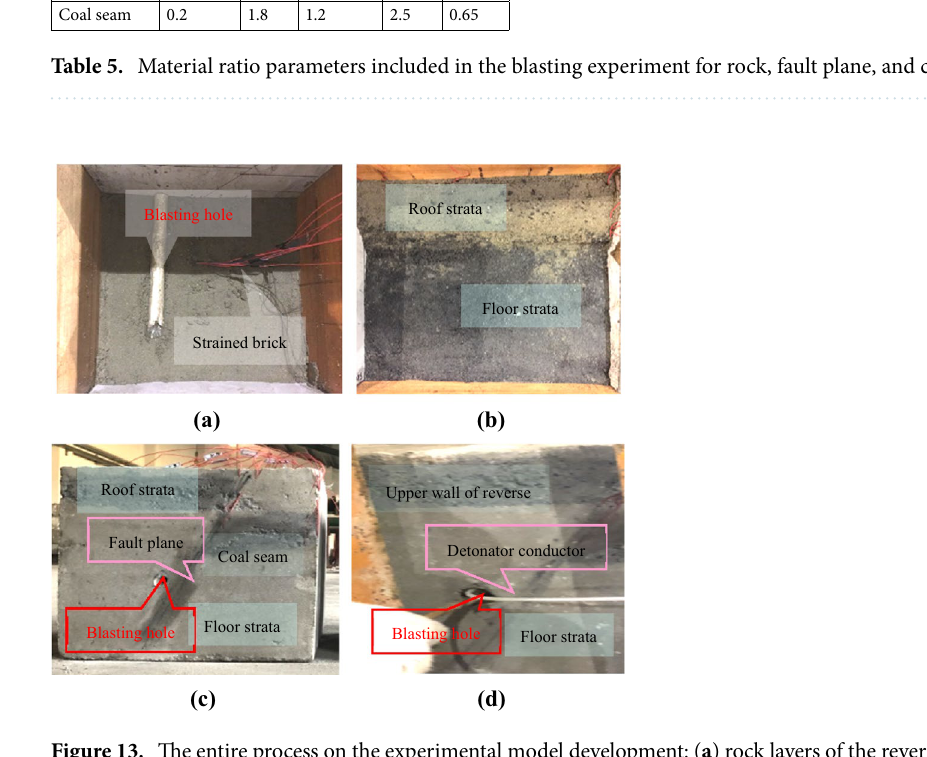
Figure 13. The entire process on the experimental model development: ( a ) rock layers of the reverse fault floor, ( b ) coal seam in the lower wall, ( c ) experimental model completion, and ( d ) charging and